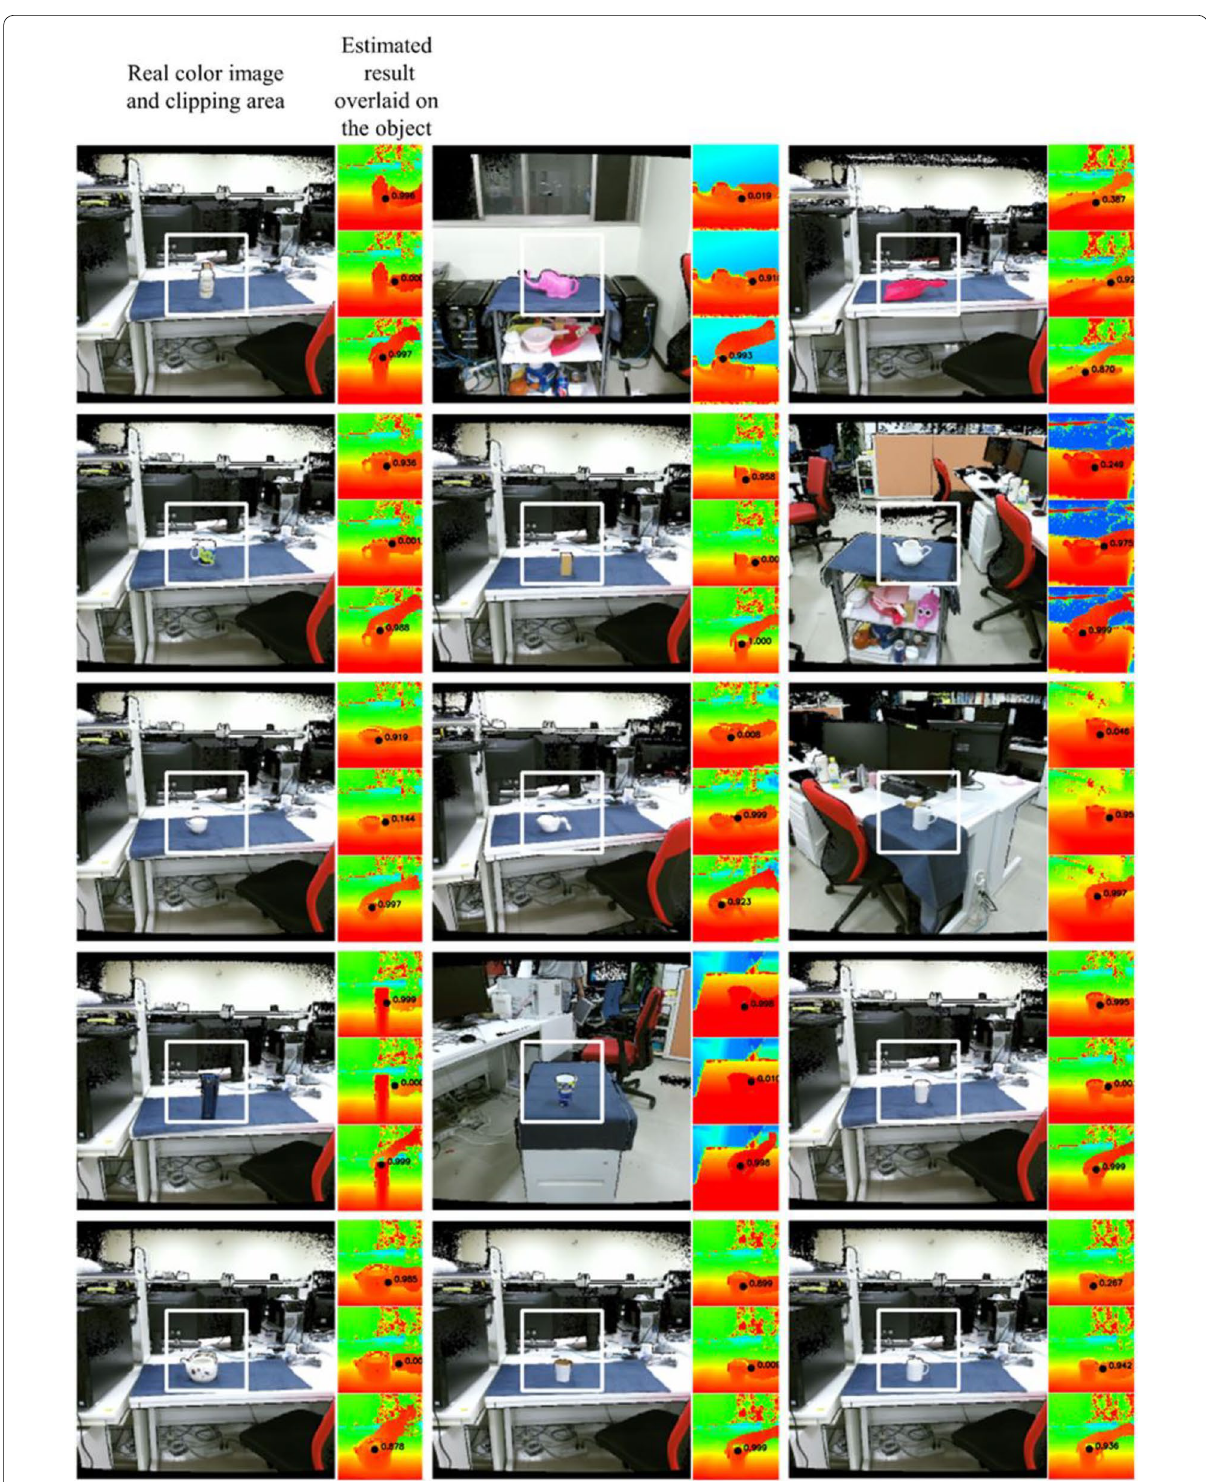
Fig. 15 The recalling results for a variety of real images. The results that are determined to be ungraspable are based on the estimated certainty, which are displayed by the dark